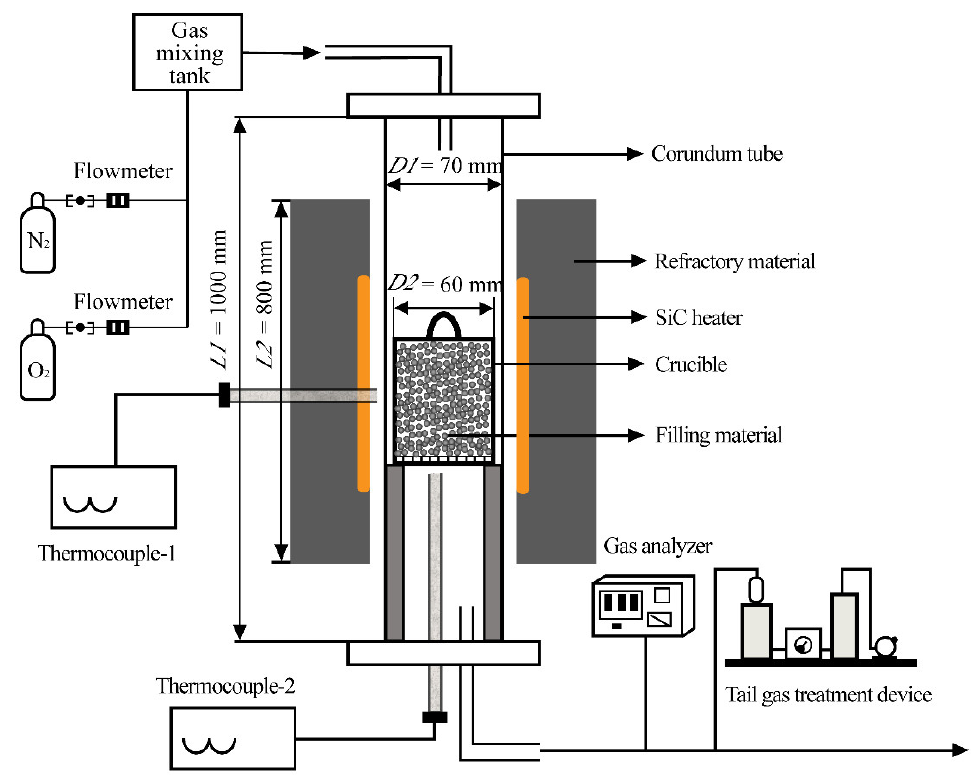
Figure 3. Schematic diagram of micro-sintering experiment apparatus.